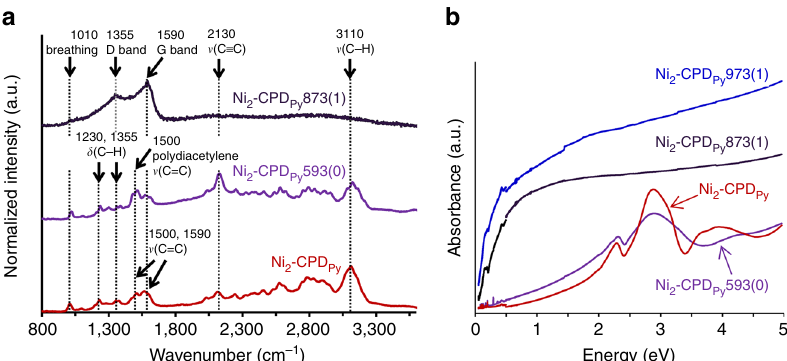
Fig. 3 Raman and UV-vis absorption spectra of Ni 2 -CPD Py and heat-treated samples. a Raman spectra: peak assignments are based on theoretical calculations (Supplementary Fig. 12) and references 36, 39 . b Absorption spectra measured by FT-IR ( < 0.4959eV) and UV-vis-NIR spectrometry ( > 0.4959eV)